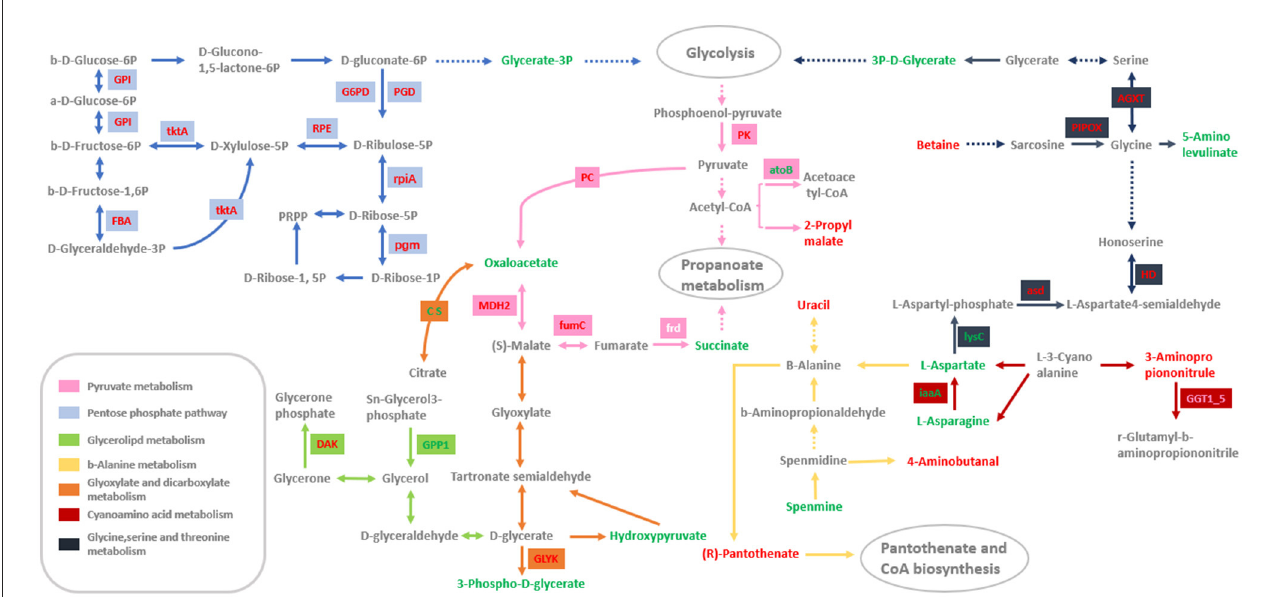
FIGURE6 The seven pathways enriched by significant DEGs and DAMs involved in mycelium growth. The small square containing words represents the DEGs that participated in this pathway. The red word in the small square indicates that this gene is upregulated within the mycelium growth, while the green word indicates that this gene is downregulated. Similarly, the red words in each pathway indicate upregulated DAMs while the green words indicate downregulated.